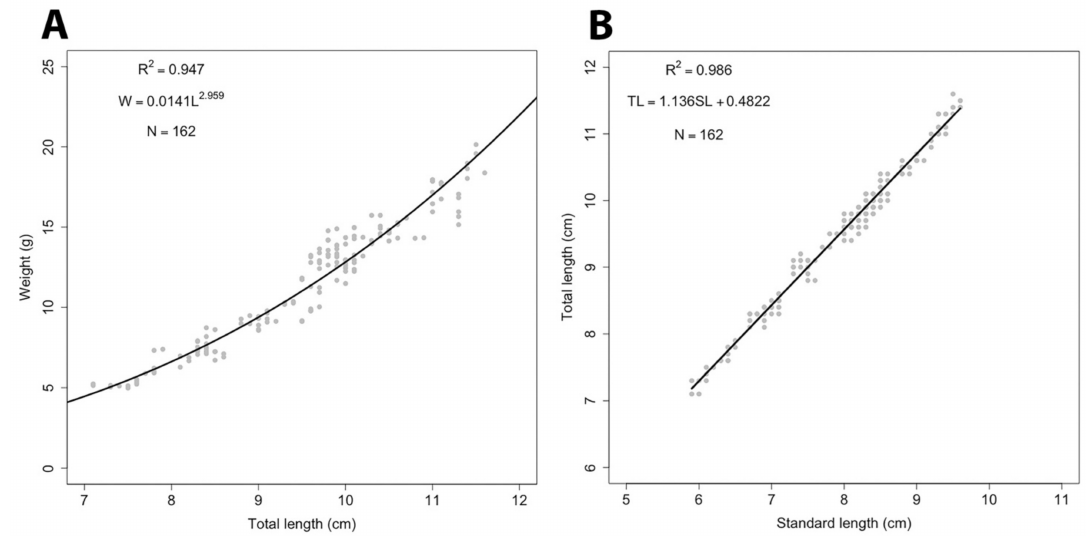
Figure 4. Total length–weight relationship ( A ) and total length–standard length relationship ( B ) of G. paganellus